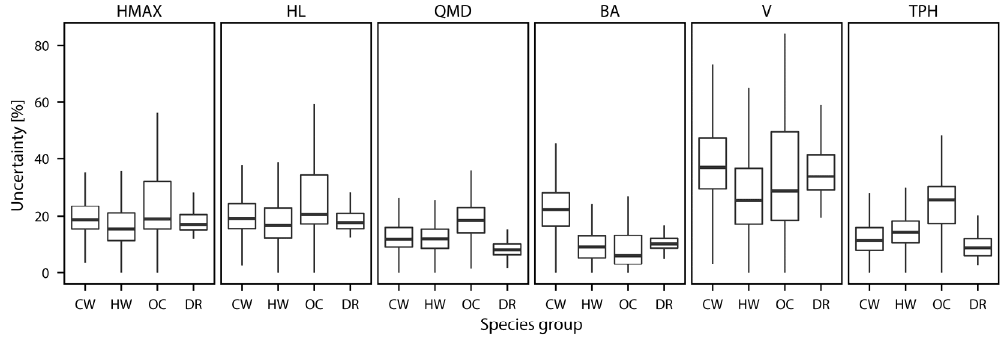
Figure 5. Uncertainty values of yield curve assignment for stand inventory